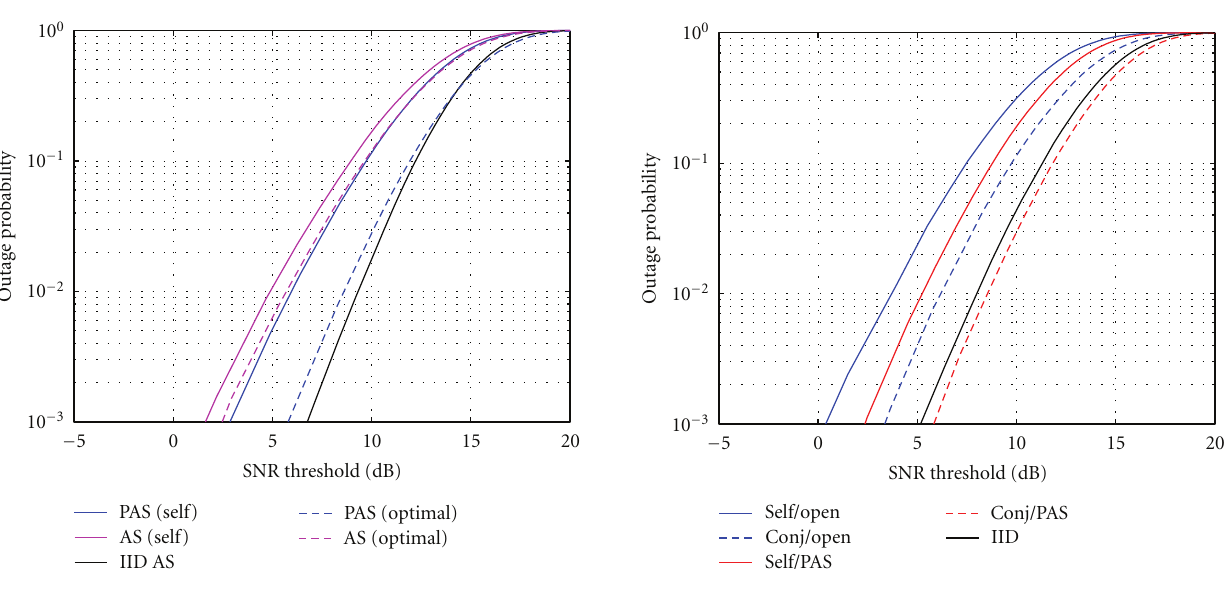
Figure 8: Parasitic switching (ULA): (5,2). Figure 9: Parasitic switching (UCA):